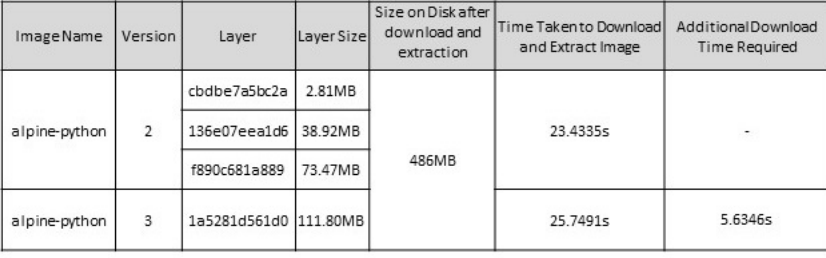
Figure 10. Shared Image Layers Size on Disk and Download